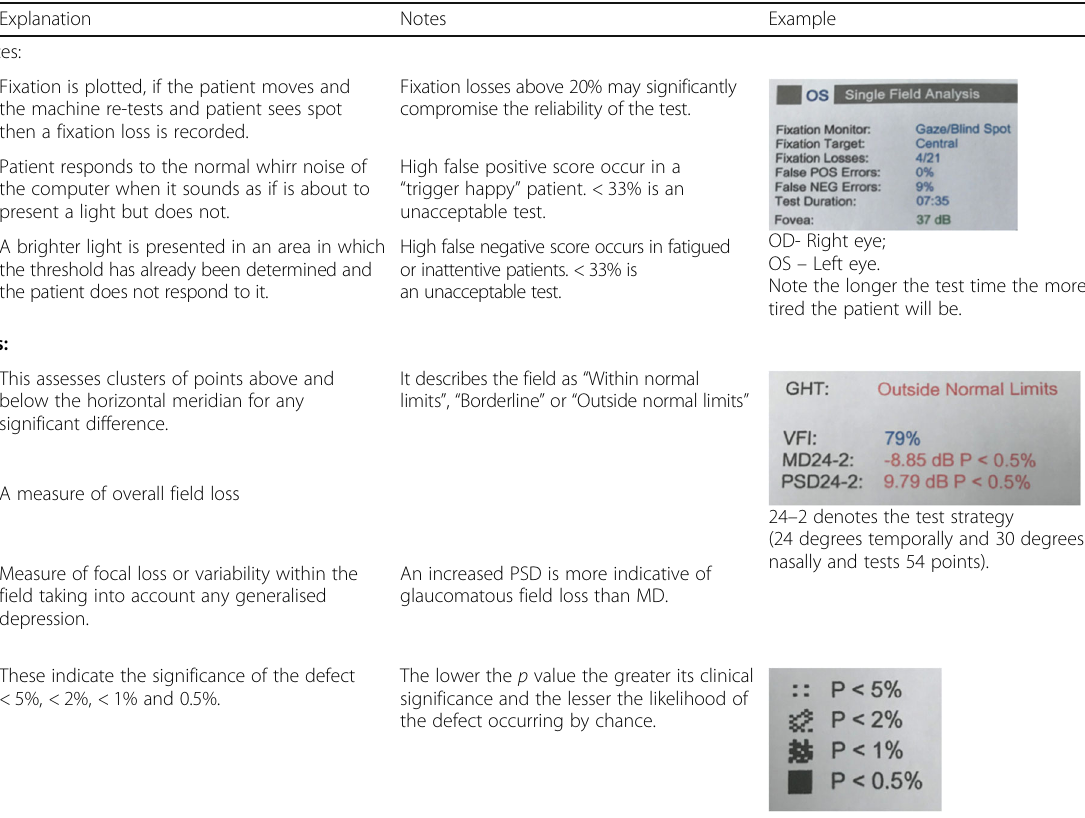
Table 3 Interpretation of Humphrey visual field